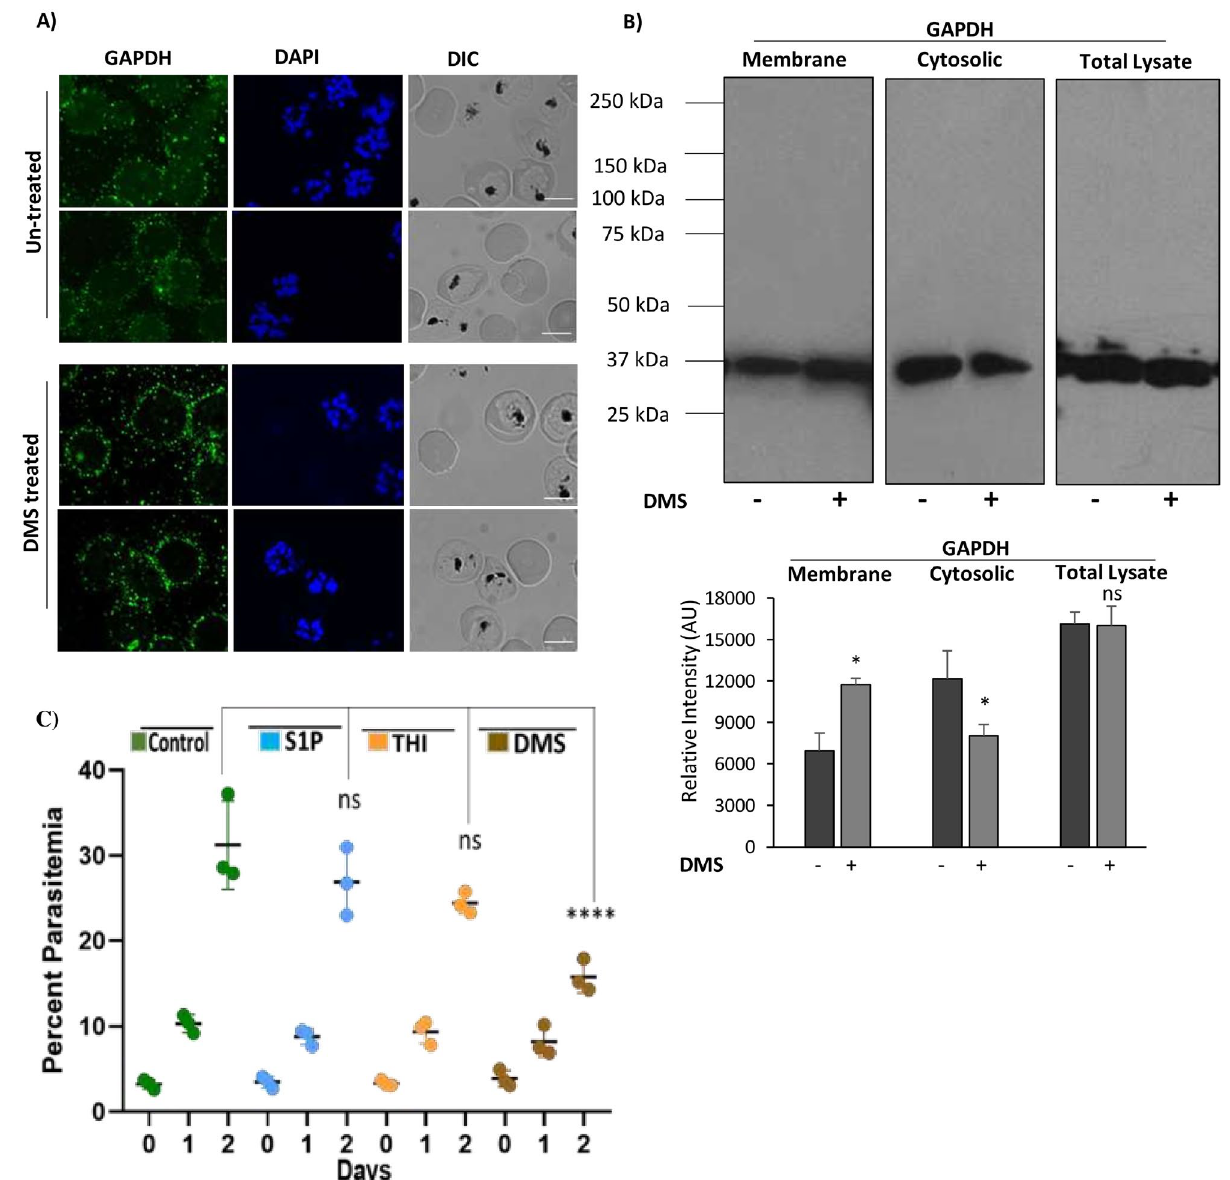
Figure 5. Translocation of GAPDH in parasite infected erythrocytes upon host SphK-1 inhibition. ( A ) Confocal micrographs demonstrate GAPDH level and localization in both DMS-treated and untreated infected erythrocytes. ( B ) Detection of GAPDH in both membrane and cytosolic fractions of DMS-treated infected erythrocytes. Total cell lysate was used as a loading control. Change in the level was plotted as relative intensities of bands detected in different cellular fractions. Three independent experiments have been done, n = 3, * p ≤ 0.05. ( C ) Antimalarial effects of S1P, THI, DMS. Groups of BALB/c mice (n = 3 per group) were inoculated with 1 × 10 8 parasitized erythrocytes of pbANKA by IP injection. Post 48 h of infection; DMS was administered by intraperitoneal route at 4 µg/kg; oral administration of 2-Acetyl-4-tetrahydroxybutyl imidazole (THI) was done at 4 µg/kg and S1P was injected intravenously at a concentration of 0.4ug/kg. Untreated control mice received 10 ml/kg of DW. The treatment was carried out for 3 consecutive days (days 0–3). Every day parasitemia was determined by microscopic examination of Giemsa stained thin blood smears. Comparative analysis among the groups, namely; DMS, THI and S1P treated mice with untreated mice done with One-way ANOVA followed by Tukey multiple comparison test, which revealed significant differences between DMS treated and untreated mice with p values, p < 0.0001****, not significant